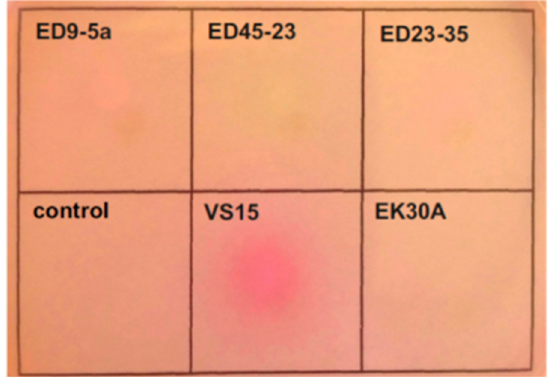
Figure 3. Evaluation of urase activity by Christensen’s method. Cultures were dropped onto a Christensen Urea Agar plate and grown overnight. Christensen liquid medium was used as a negative control